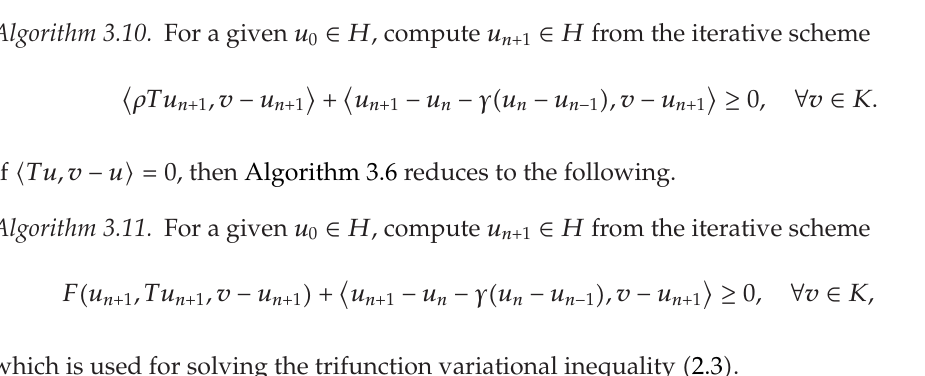
Algorithm 3.10. For a given u 0 ∈ H , compute u n (cid:7) 1 ∈ H from the iterative scheme